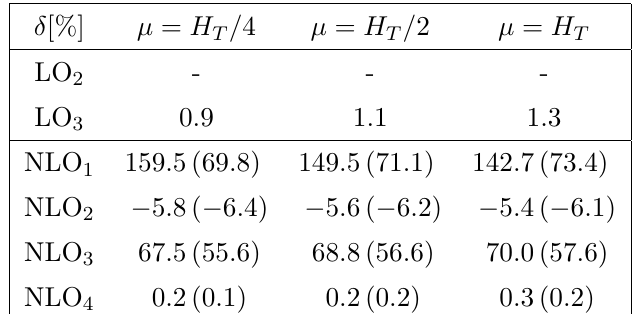
Table 4 . (cid:27) =(cid:27) LO ratios for t (cid:22) tW (cid:6) production at 100 TeV for various values of (cid:22) = (cid:22) r = (cid:22) f . (N)LO i QCD